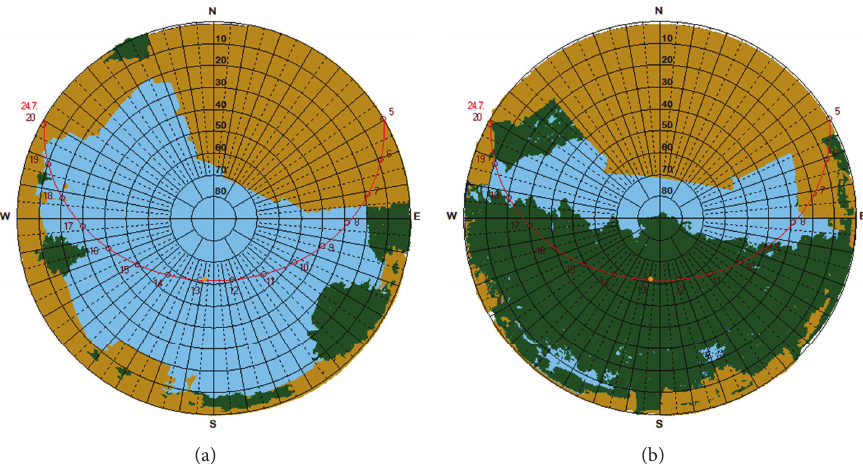
Figure 4: Fish-eye photos from the upper hemisphere at the sunny (a) and shaded (b) site during the human-biometeorological measuring campaign in Freiburg on July 24, 2008 [2, 13].